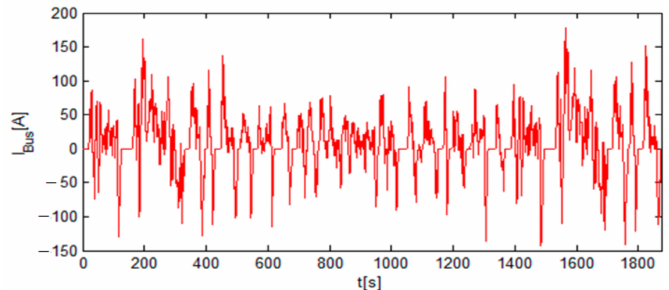
Figure 15. Load current